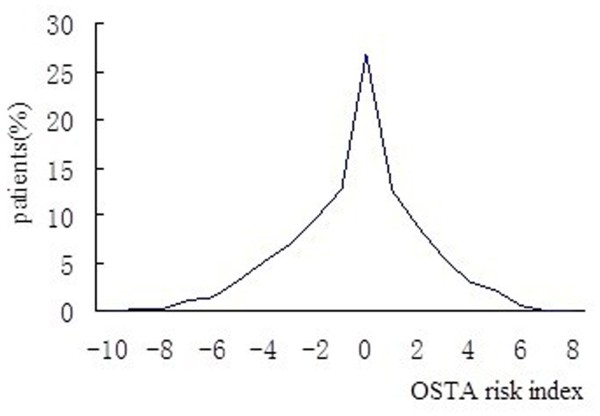
Distribution of study patients according to their OSTA risk index.